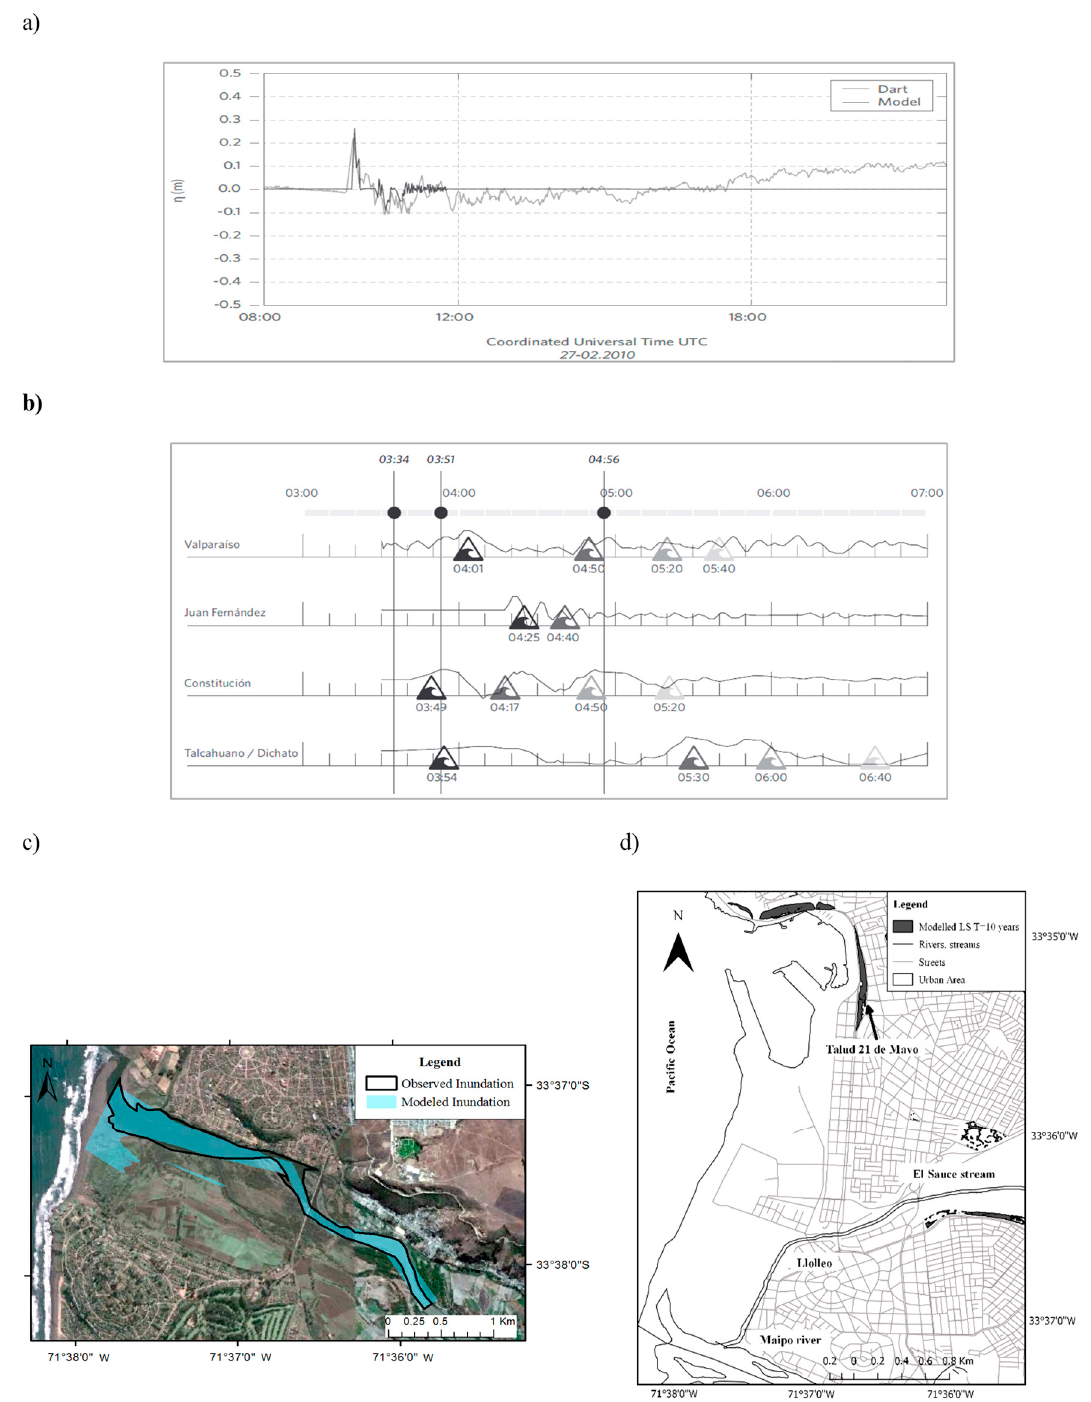
Figure 4. Validation of natural hazard models. ( a ) Validation of the SWAN model by comparing the far-field wave simulation to the DART buoy measures located in the coast of Perú. ( b ) Validation of the near-field SWAN model waves by comparing simulated times of arrival to different Chilean coastal cities against observations published in local media. ( c ) Validation of the flood inundation model using the flooded area retrieved from Google Earth V 6.2 for 8 October 2009. ( d ) Validation of the landslide model through the simulation of the landslide occurred on 28 May 2013 in Talud 21 de Mayo zone under the 5- to 10-year precipitation event.